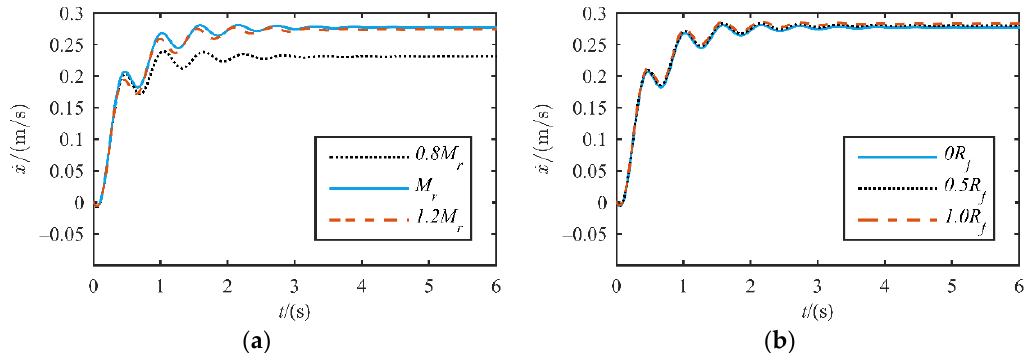
Figure 8. The velocity curve of the robot under different parameters. ( a ) Different rotator masses, ( b ) Different roughness coefficients of the spherical shell.